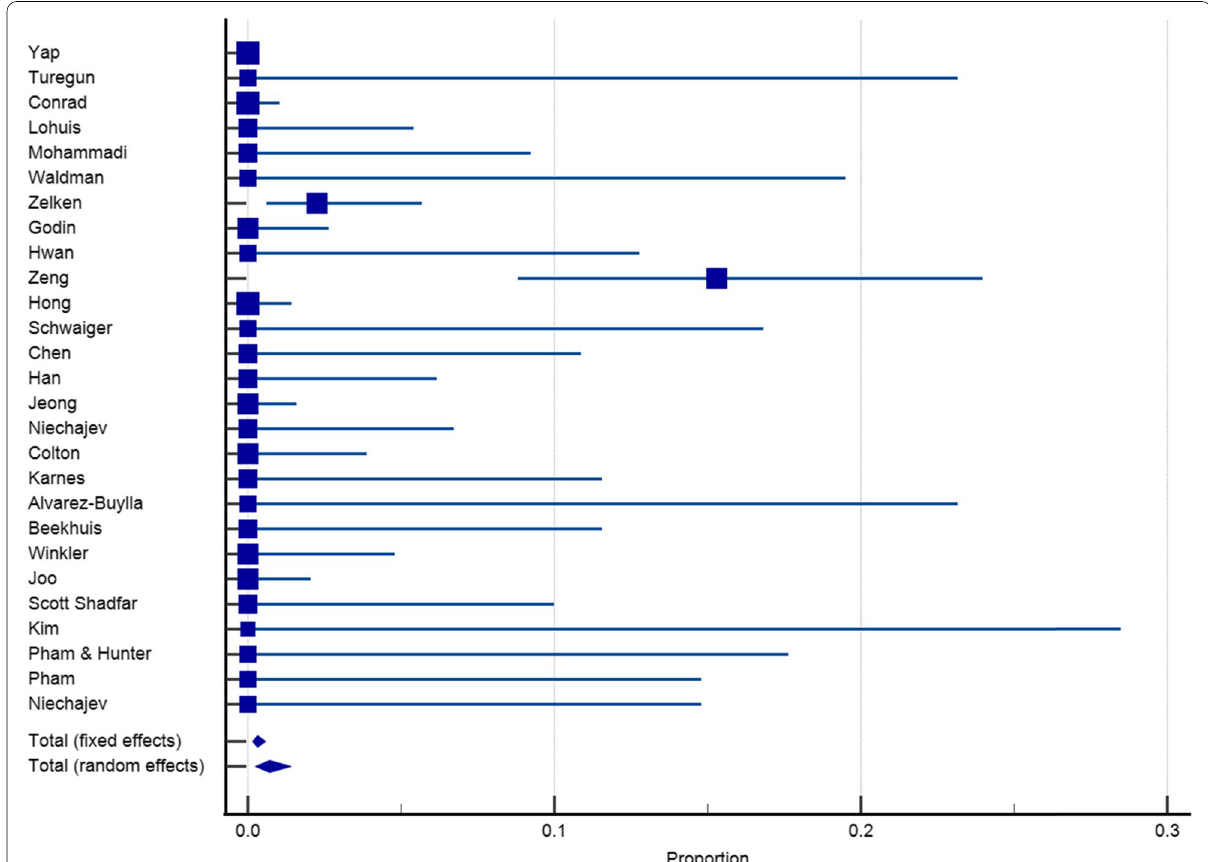
Fig. 6 Hematoma rates reported for synthetic materials in both fixed and random-effects